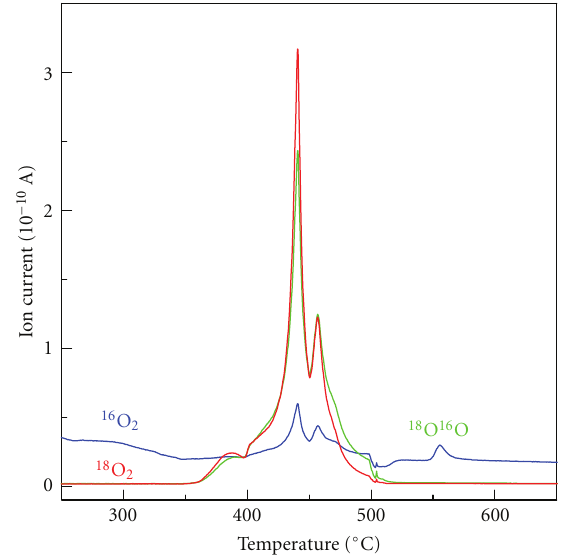
18 O 16 O, and 16 O 2 , 2 molecules (red, green, and blue color, resp.) obtained during heating of the sample in a stream of helium. This graph shows that the 18 O isotope fraction in the samples is bigger than 70% (see